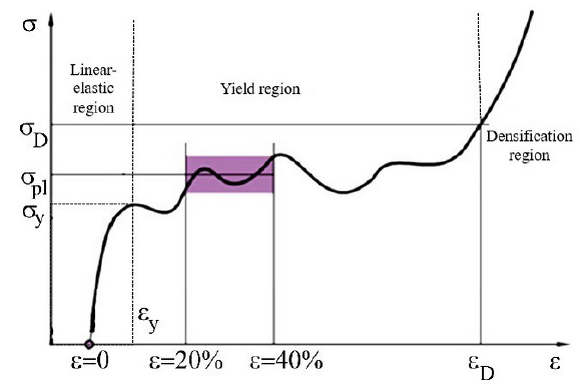
Figure 2: A typical stress-strain curve for determining mechanical properties of porous metal composites in compression tests